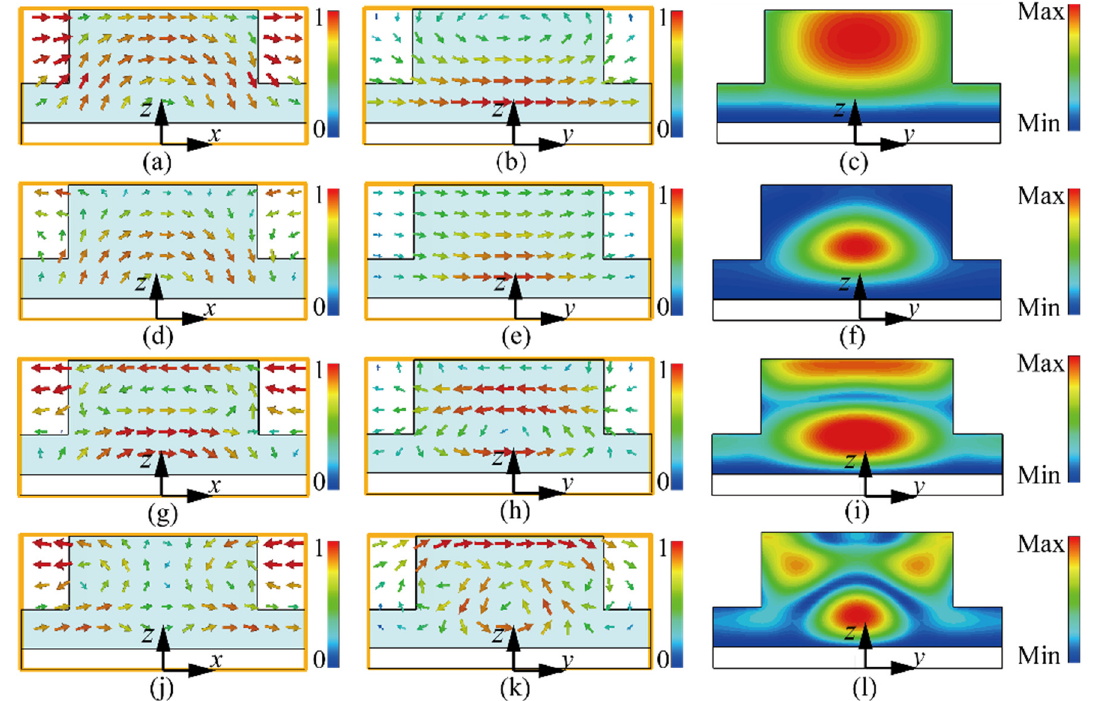
Figure 4. Simulated vector field distribution in the absorber. ( a , c , e , g ) E -field in xoz plane for f 1 , f 2 , f 3 , and f 4 of 4.41, 6.24, 8.61 and 10.76 GHz, respectively. ( b , d , f , h ) H -field in yoz plane for f 1 , f 2 , f 3 , and f 4 of 4.41, 6.24, 8.61 and 10.76 GHz, respectively. ( i , j , k , l ) Power loss density of the resonator in yoz plane for f 1 , f 2 , f 3 , and f 4 of 4.41, 6.24, 8.61 and 10.76 GHz, respectively.